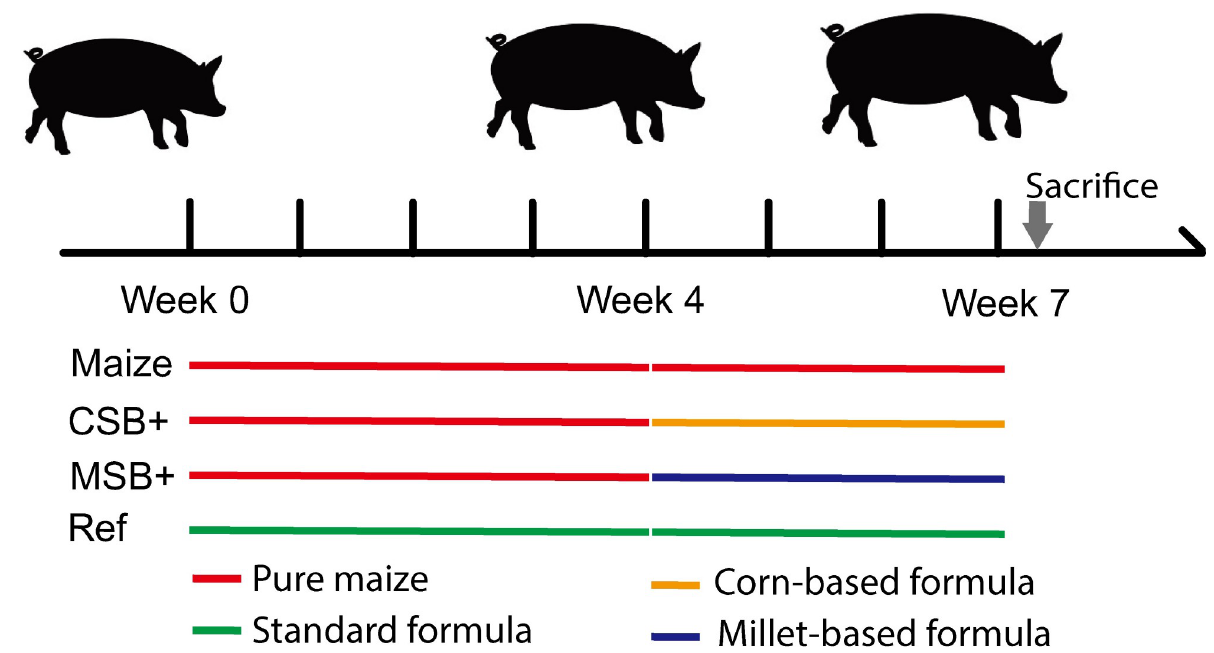
Fig 1. Different treatments between malnourished pigs and